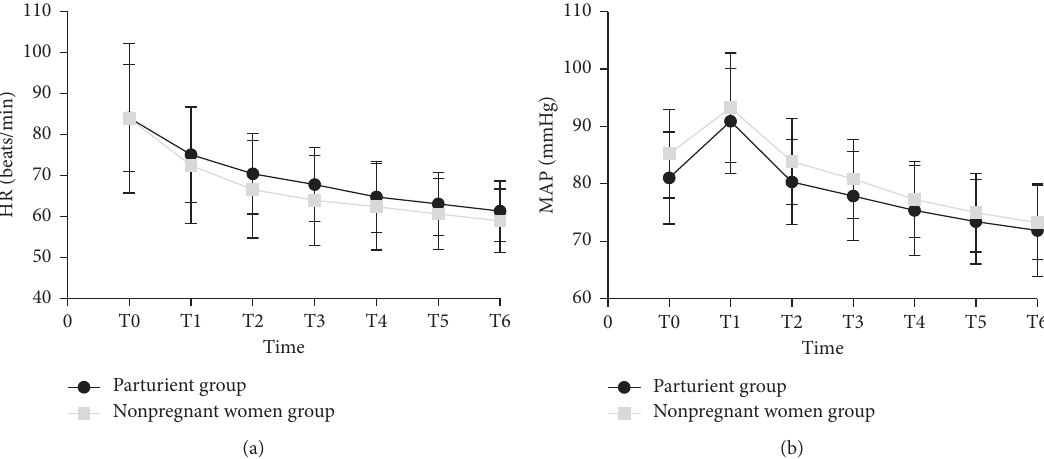
Figure 4: The HR (a) and MAP (b) in both groups at different time points. HR, heart rate; MAP, mean arterial pressure; T0, before dexmedetomidine administration; T1, T2, T3, T4, T5, and T6, 5min, 10min, 15min, 20min, 25 min, and 30min after dexmedetomidine infusion